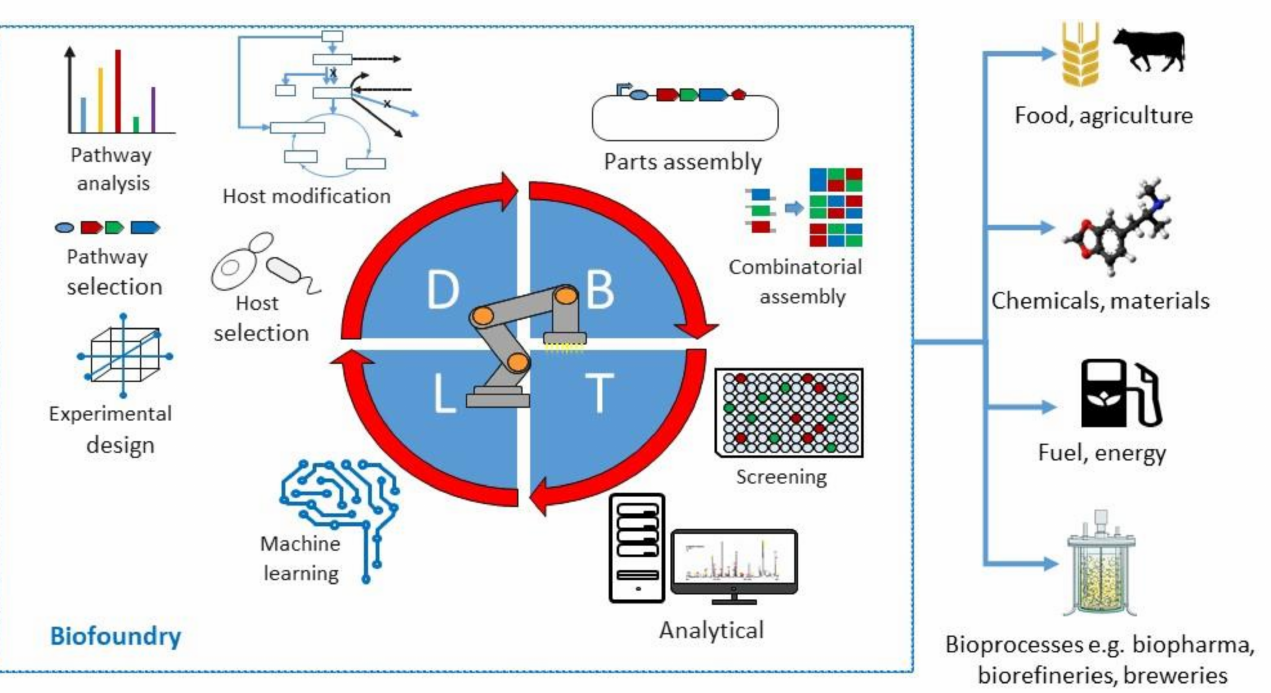
Figure 3. The biofoundry and the design-build-test-learn (DBTL) concept as a platform for manufacturing across a range of sectors. Adapted from